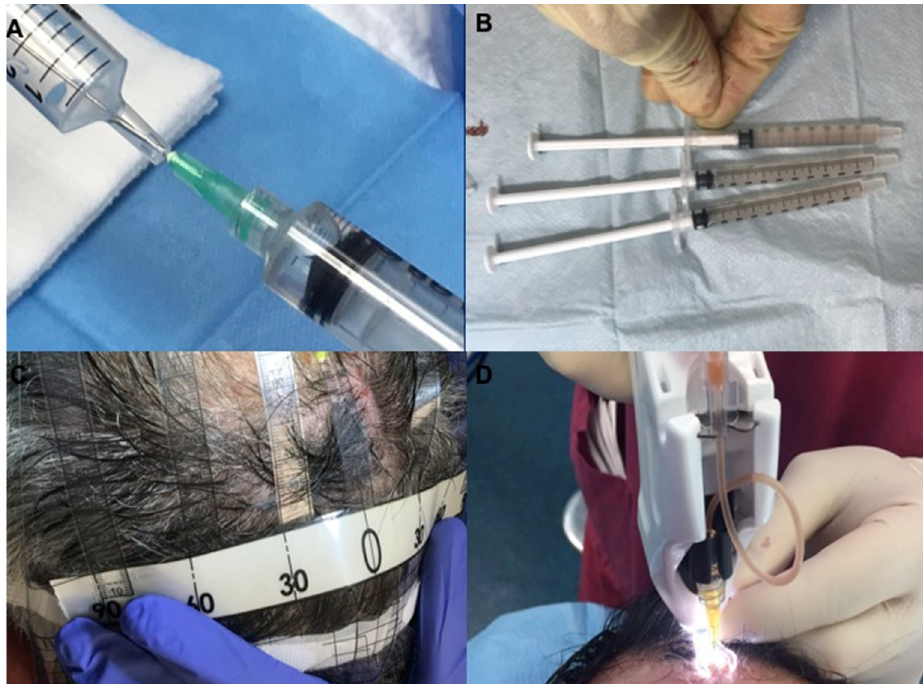
Figure 8. Micro-grafts preparation. Step 3 (Collection of micro-grafts’ suspension and infiltration). ( A ) Removing 1.5 mL of supernatant, ( B ) detail of syringes containing micro-grafts suspension, ( C ) the selected area of the scalp treated identified by specific centimeter, ( D ) mechanical and controlled infiltration performed by mesotherapy gun.